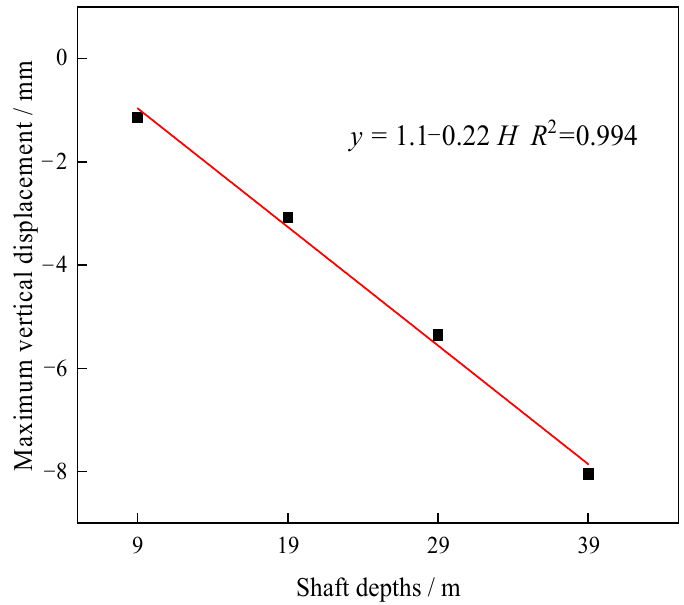
Figure 19. Relationship between maximum vertical displacement and shaft depth.